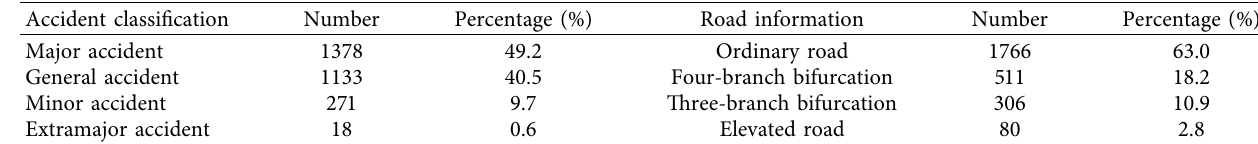
Figure 1: Flow of random forest Table 1: Analysis of partial accident data.